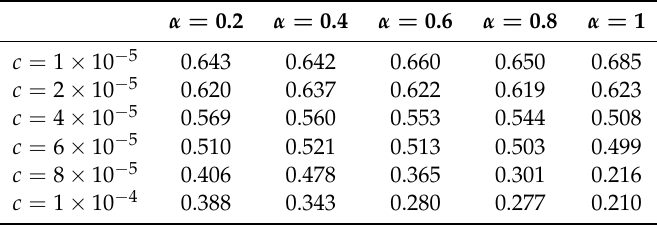
Table 4. The change of modularity with the increase of ∆ t about different